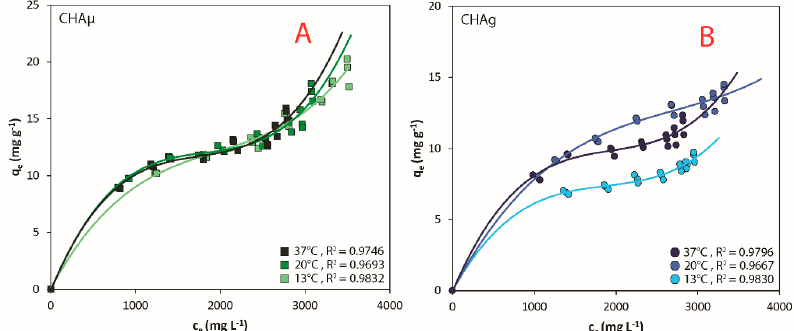
Figure 1. Equilibrium adsorption capacity q e (mg g − 1 ) against equilibrium concentration C e (mg L − 1 ) after a contact time of 20 h with centrifuged swine manure (CSM): ( A ) trends for CHA µ (3rd degree polynomials) at 13, 20, and 37 ◦ C and respective R 2 values; ( B ) trends for CHAg (3rd degree polynomials) at 13, 20 and 37 ◦ C and respective R 2 values. Both CHA µ and CHAg have shown an equilibrium trend of the L3 type following the classification proposed by Giles et al. [66]. Table 1. Parameters calculated by Harkins-Jura, Freundlich, and Langmuir isotherms (Equation (2), Equation (4) and Equation (7) respectively) for CHA µ and CHAg, at temperatures T = 286, 293, and 307 K (13, 20 and 37 ◦ C). Initial pH and NH 4 + load were 8.07 ± 0.03 and 3140 ± 45 mg L − 1 respectively.